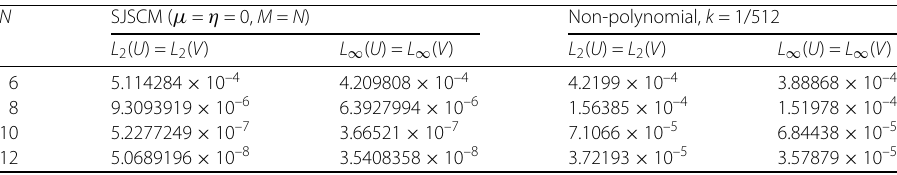
Table 4 L 2 and L ∞ error norms for u ( x , t ) = v ( x , t ) of Example 1 when 0 ≤ x ≤ 3, α 1 = α 2 = 0.2